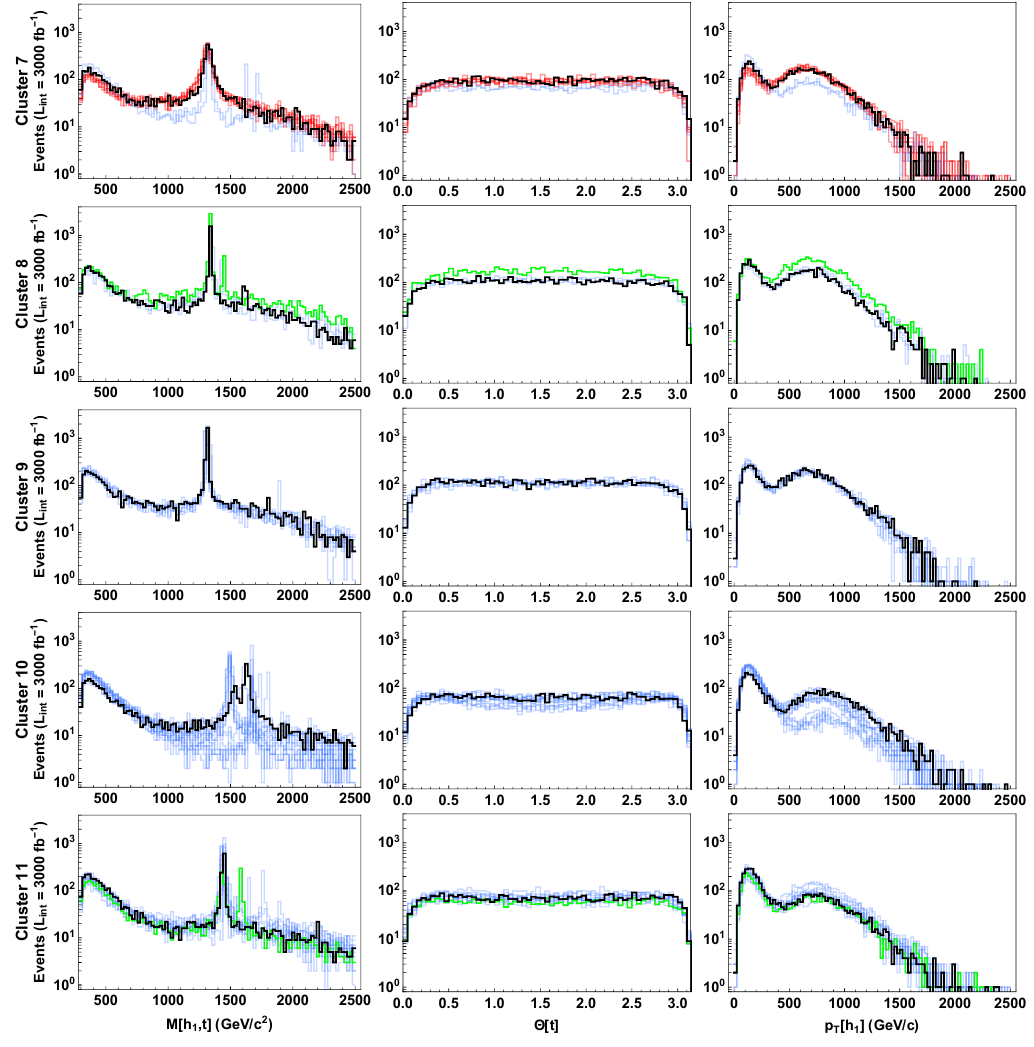
√ Figure 12 . Distributions at s = 14 TeV for the invariant mass of the pair composed by top and most energetic Higgs (first column), angular distribution of the top (second column) and transverse momenta of the most energetic Higgs, organized in clusters by similarity (clusters 7 through 11). Red and blue curves indicate respectively points in Regions I and II of the MCHM 5 , the benchmark point for each cluster is shown in black and the example points of table 1 are shown in green ( P 3 is in cluster 8 and P 1 is in cluster